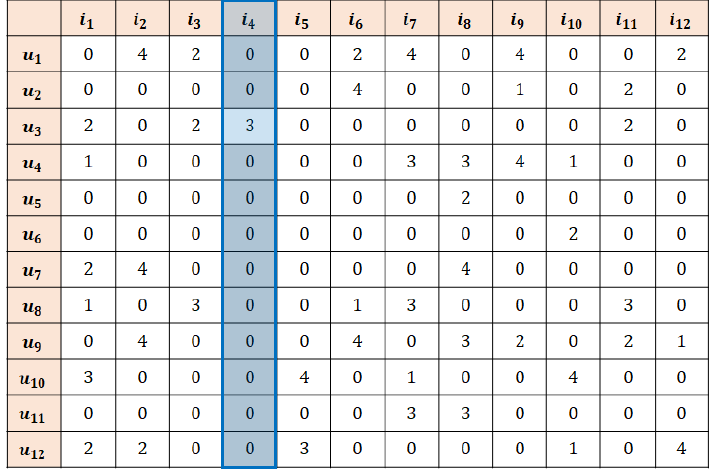
Figure 5. An example of missing data imputation of k-RRI (step 3).